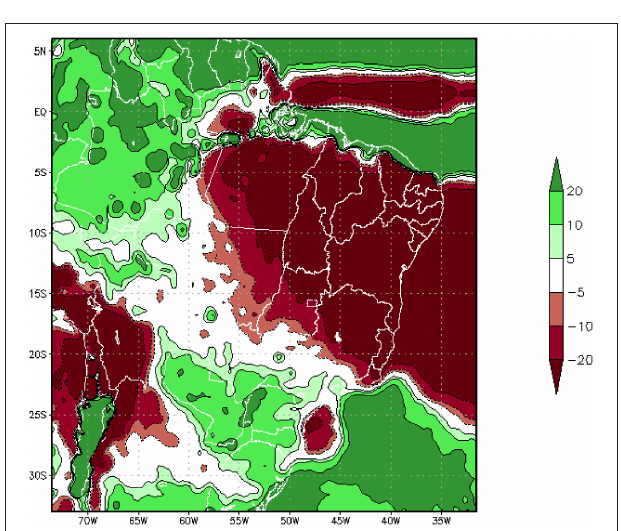
FIGURE 5 | Same as Figure 3, but for temperature changes ( ◦ C) on the period between 2071 and 2100.